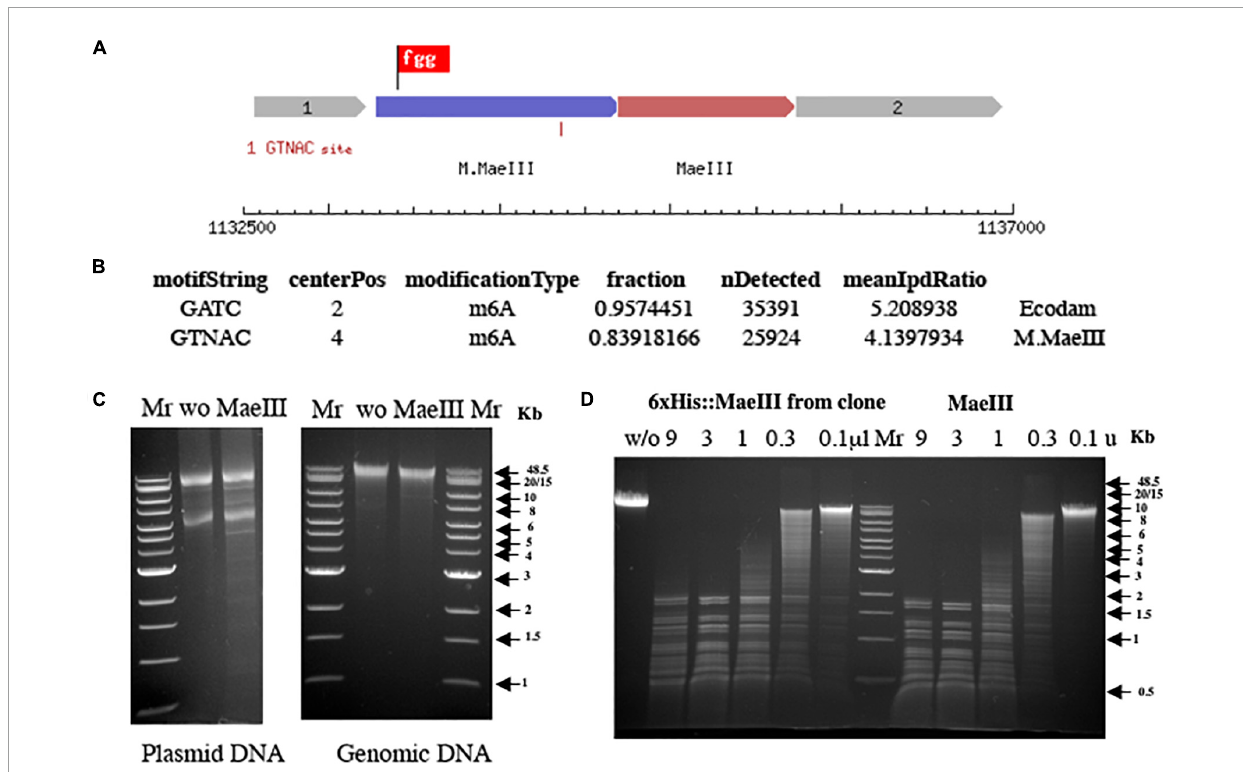
FIGURE5 Schematic presentation of the Mae III restriction-modification system (A) . Motif and modification analysis by SMRT sequencing of gDNA from E. coli strain ER3081 [pM. Mae III] (B) . Note that this strain contains a Dam MTase in addition to M. Mae III. Mae III methylation protection assay on both plasmid and gDNA from E. coli 3081[pM. Mae III] strain (C) . Plasmid and gDNA from E. coli 3081[pM. Mae III] were purified and 1 µ g of each DNA was incubated without (w/o) as a negative control or with 1 unit of Mae III restriction enzyme at 55 ◦ C for 1 h in 1 × Mae III commercial buffer (Roche Diagnostic, GmbH, Mannheim, Germany). The results demonstrated that both plasmid, and gDNA are resistant to Mae III restriction endonuclease digestion due to modification of the DNA in vivo by M. Mae III methyltransferase at GTNAC sites. λ DNA digestion patterns obtained by titration of restriction endonuclease activity from 250 mM imidazole Ni-NTA column elution fraction from E. coli clone 3081[pM. Mae III + pET21b 6 × His: Mae III] expressing Mae III enzyme compared to Mae III restriction enzyme from Roche on the same DNA substrate (D) . 1 µ g of λ DNA incubated with Ni-NTA imidazole elution fraction of 6 × His: Mae III serial 3 × dilution (from 9 to 0.1 µ l) and serial 3 × dilution of commercial Mae III enzyme (from 9 to 0.1 units) for 1 h at 55 ◦ C in 1 × Mae III commercial buffer (Roche Diagnostic, GmbH, Mannheim, Germany). 2 × Buffer contains 40 mM Tris–HCl, 550 mM NaCl, 12 mM MgCl 2 , 14 mM 2-mercaptoethanol, pH 8.2 (+55 ◦ C). The reaction mixtures were separated on 0.8% agarose gel in TBE buffer and visualized by staining with ethidium